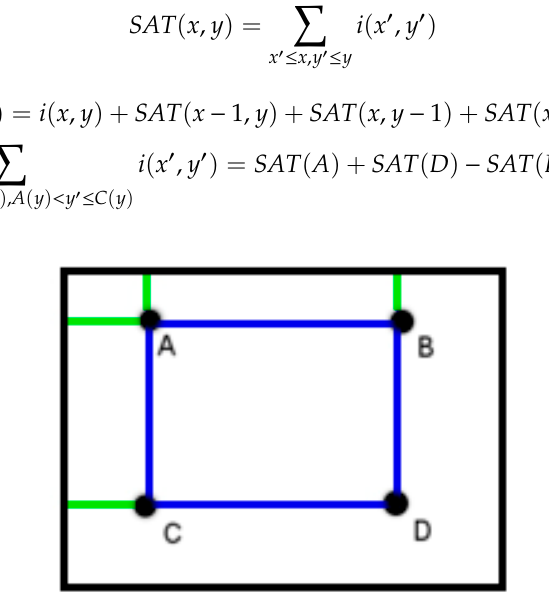
Figure 6. Region definition in a Summed Area Table (SAT).